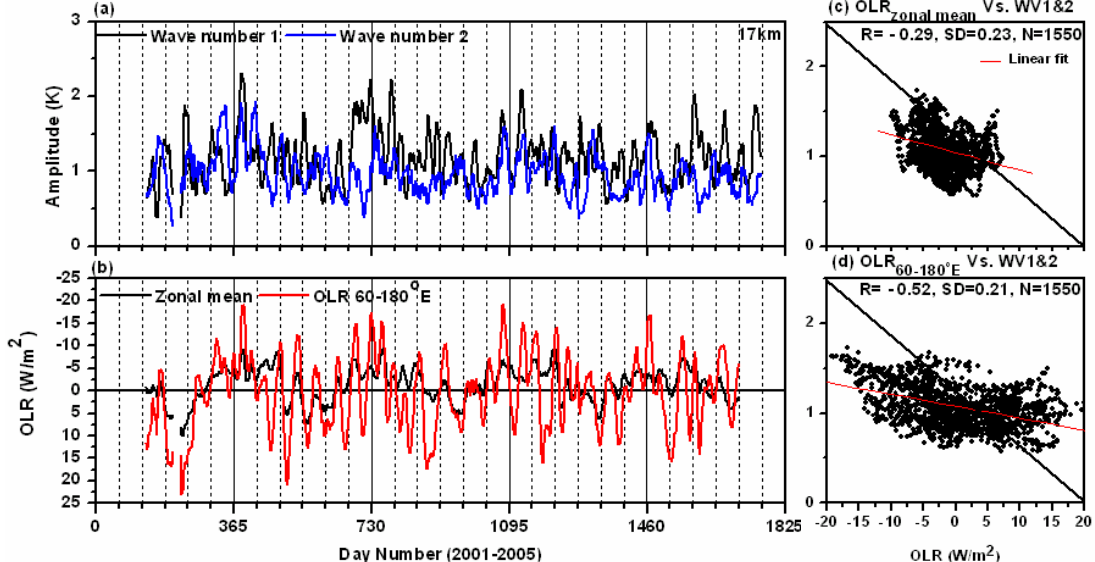
Figure 5. Long-term time series of (a) Kelvin wave amplitudes of wave numbers 1 and 2 observed using CHAMP/GPS measurements at the 17-km altitude region. (b) Corresponding outgoing long-wave radiation (OLR) anomalies (from yearly mean) observed in between 10 ◦ N and 10 ◦ S averaged in between 60 ◦ E and 180 ◦ E longitude (red) and 180 ◦ W to 180 ◦ E (zonal average) longitude (black). For clarity a 15-day running mean was applied in both panels. Cross correlation observed between the amplitudes of Kelvin waves with both the wave numbers (c) vs. zonal mean OLR anomalies and (d) vs. 60 ◦ E and 180 ◦ E longitude band.